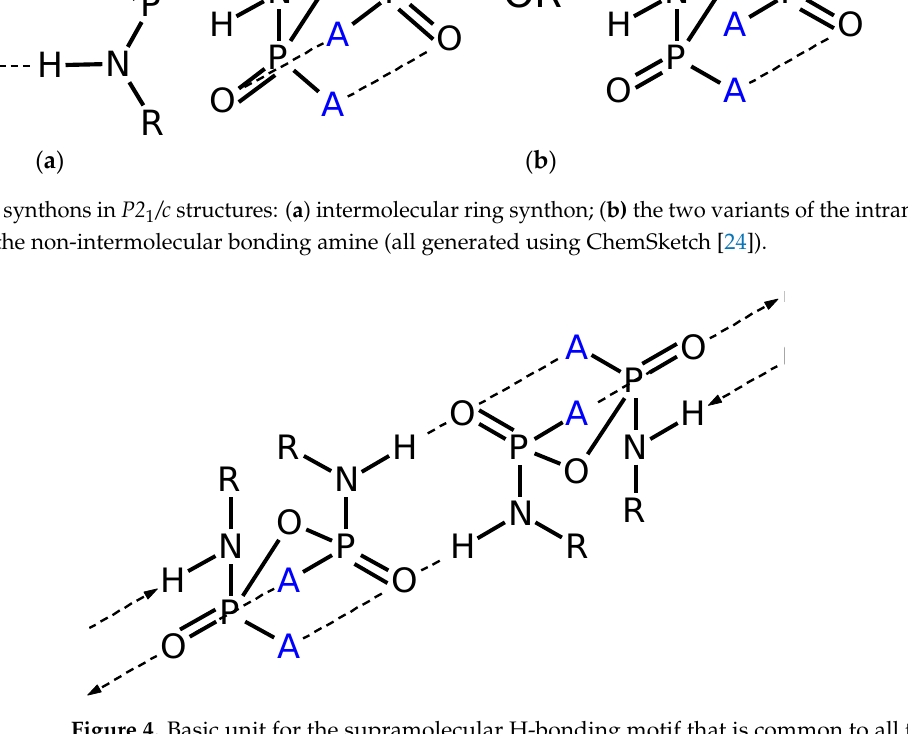
Figure 4. Basic unit for the supramolecular H-bonding motif that is common to all three mono-N- substituted pyrophosphoramides crystallising in P 2 1 / c (generated using ChemSketch [24]).